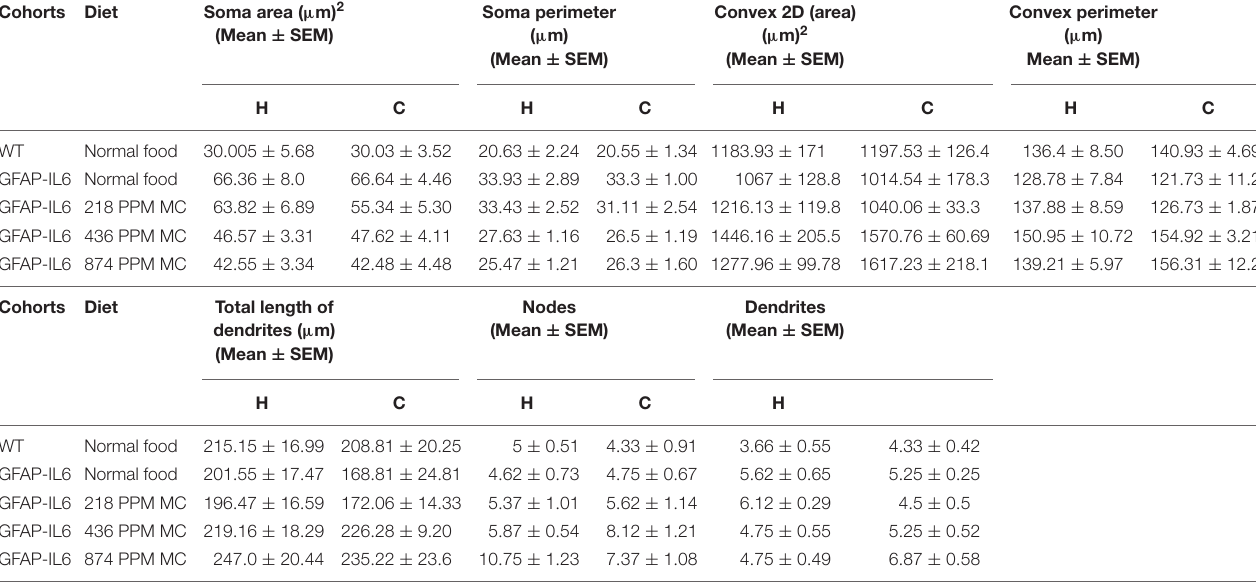
TABLE 3 | Morphological analysis of Iba-1 + microglia. Cohorts